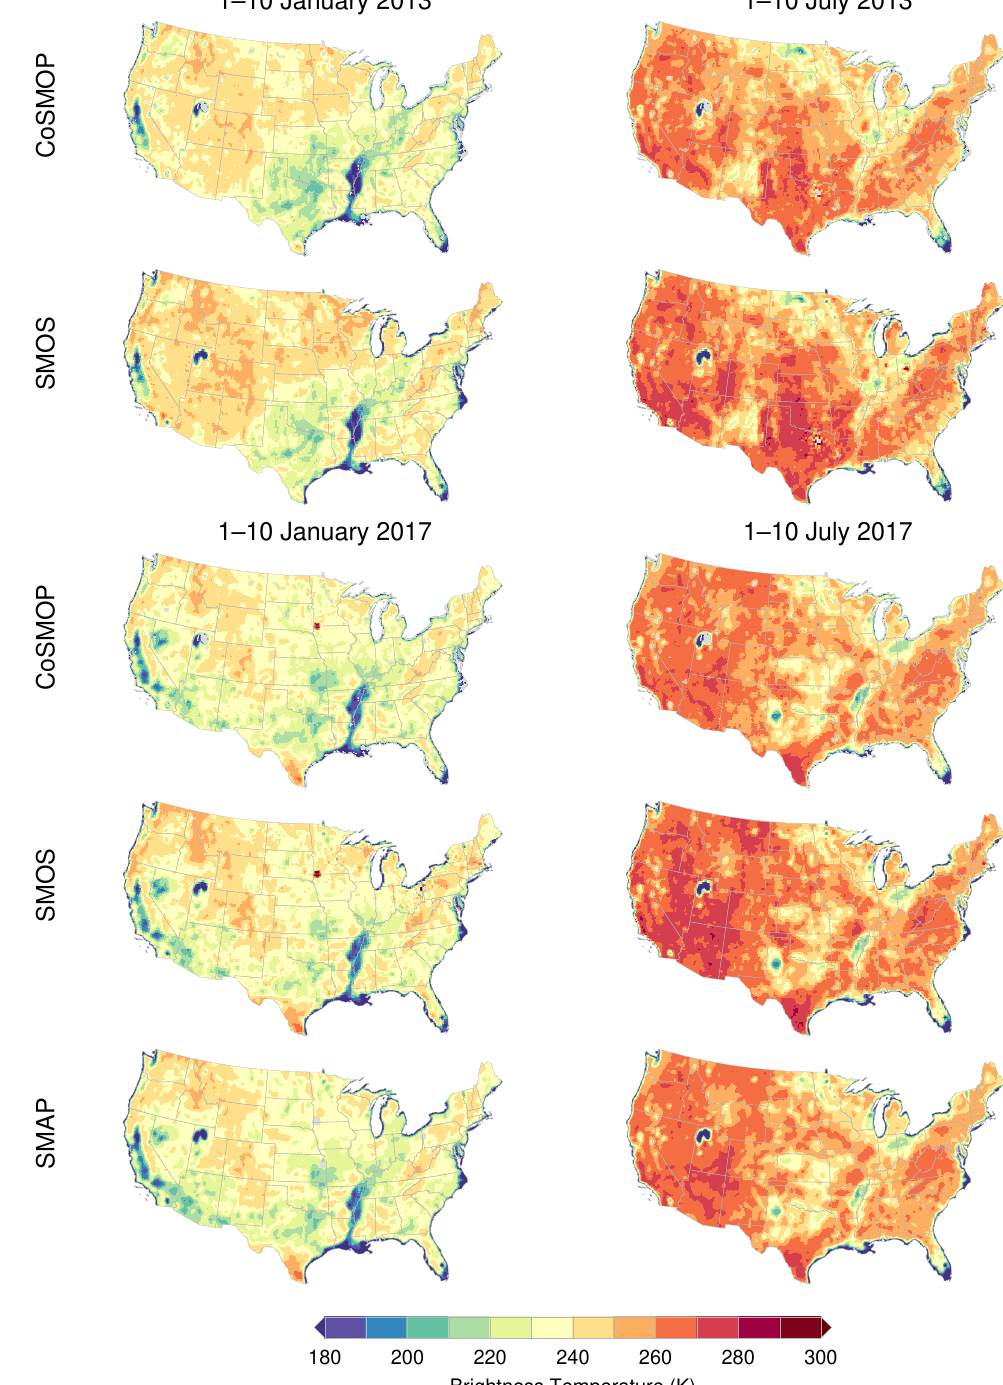
Figure 4. 10-day average brightness temperatures from CoSMOP, SMOS, and SMAP_E, computed from 1–10 January 2013 and 2017 (left column) and from 1–10 July 2013 and 2017 (right column) , respectively, for the Contiguous United States (CONUS)